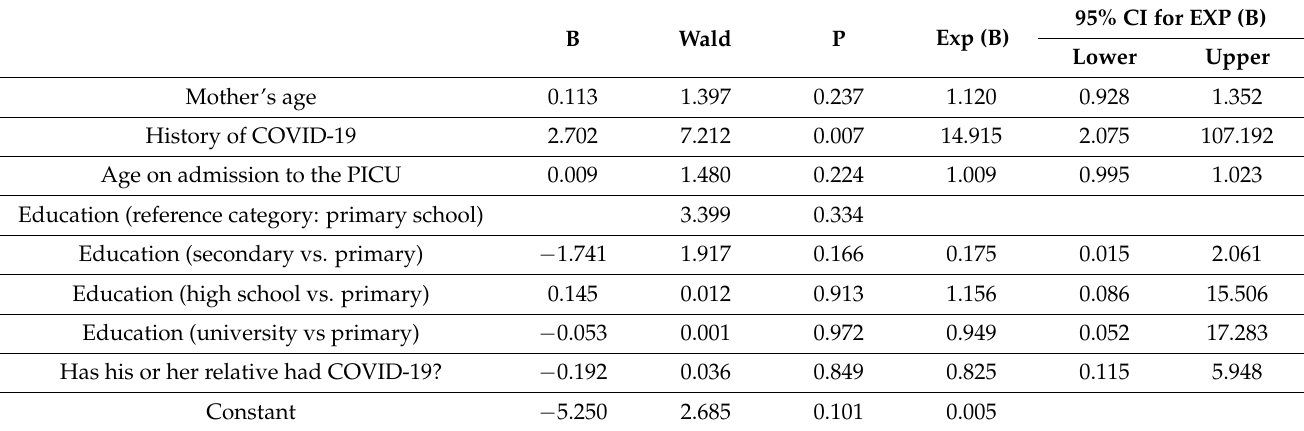
Table 5. Computer output of the logistic regression model for the presence of